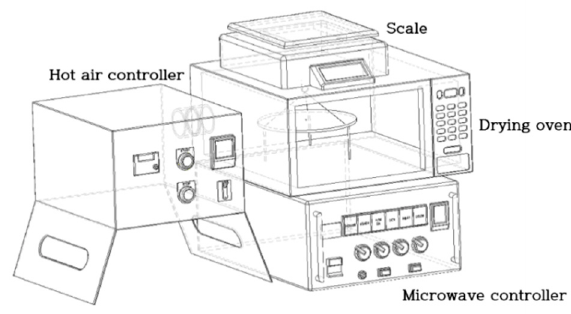
Figure 1. Schematic diagram of microwave and hot-air combination dryer.